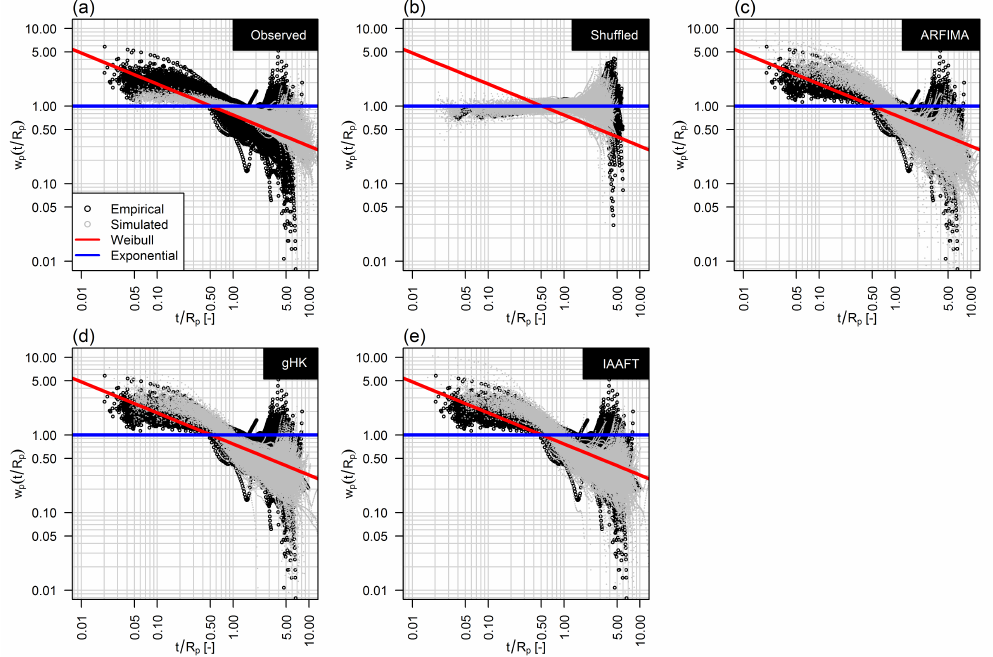
Figure 12. Hazard functions based on the standardized return intervals between standardized flow values exceeding the 95% quantile threshold. Similar to Figure 10, in all panels but ( b ), black circles indicate the hazard functions corresponding to the observed series. In panel ( b ) black circles indicate the hazard functions corresponding to the observed shuffled (uncorrelated) data. Grey circles denote hazard functions resulting from simulation by Weibull distribution ( a ); standard exponential distribution ( b ); ARFIMA ( c ); gHK ( d ); and IAAFT ( e ). Each panel also shows theroretical standard exponential hazard functions (blue line) and Weibull hazard functions (red line) with shape parameter equal to the average value of H computed by